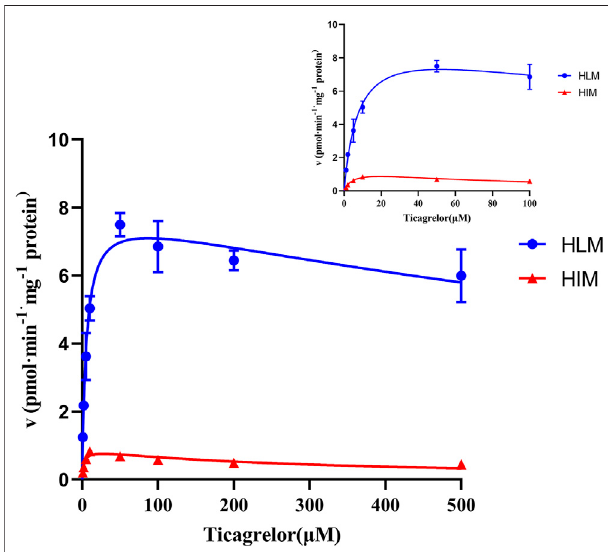
FIGURE 2 | Enzyme kinetics of ticagrelor glucuronidation by HLM and HIM. Each point represents the mean ± S.D. of triple incubations.